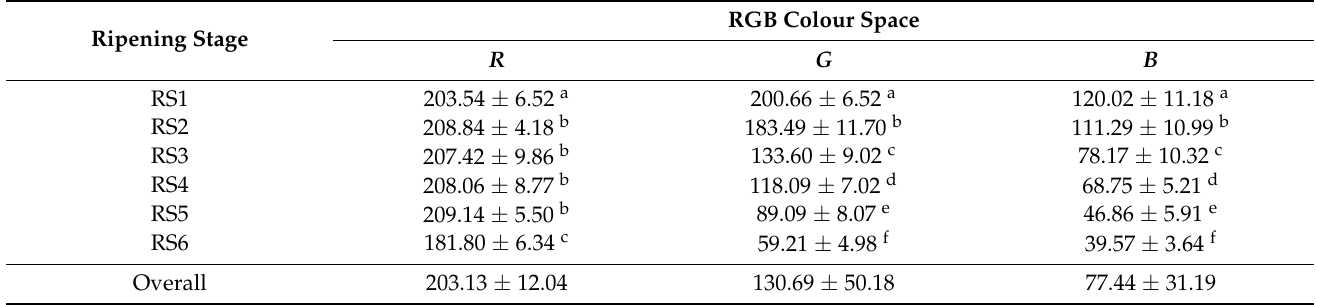
Table 2. Values of RGB (Red: R , Green: G , Blue: B ) colour space in strawberry fruits at six stages of ripening.